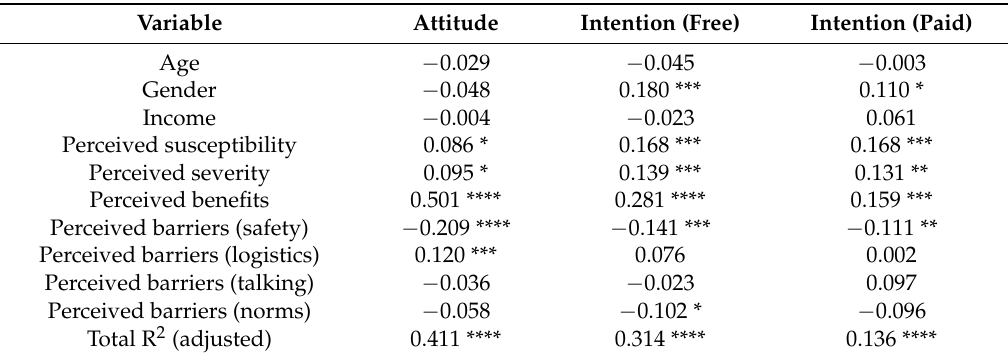
Table 3. Results of Multiple Regressions for Hypotheses.